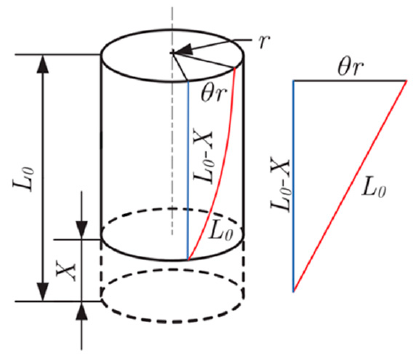
Figure 4. Helix’s geometry model for TSA.